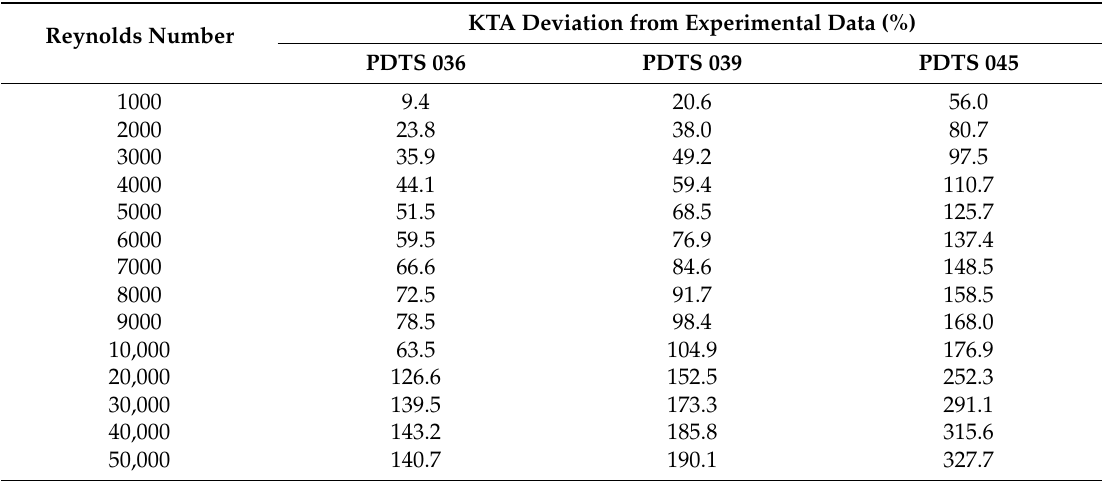
Figure 20. Predicted and calculated friction factors for PDTS 036 homogeneous porosity test section [41]. Percentage differences between KTA prediction and experimental friction factors for homogeneous porosity test sections are also presented in Table 8. Table 8. Percentage difference between predicted and experimental friction factors